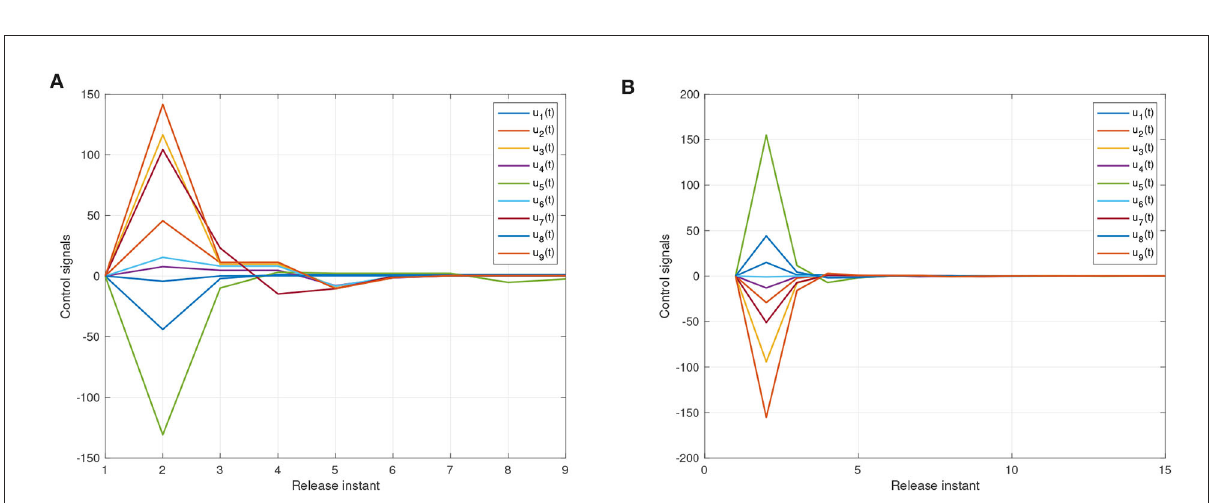
y ( t ) x ( t ). (B) Instants for anti-synchronization ε ( t ) = −